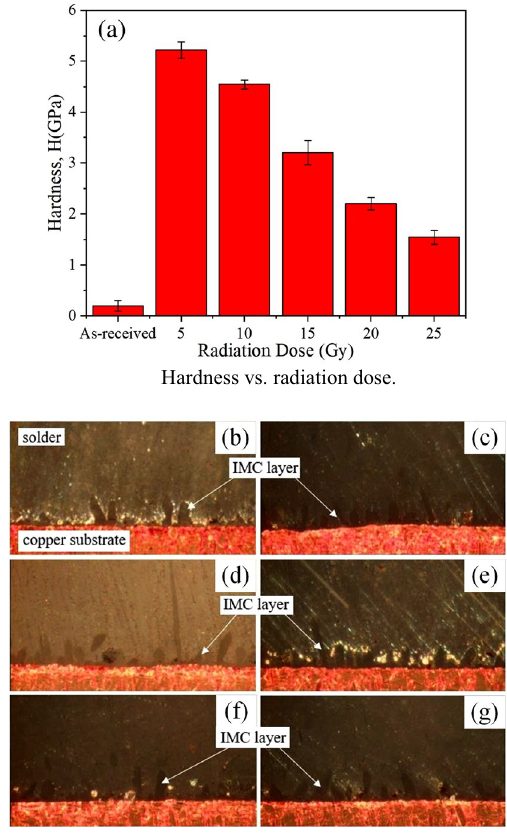
Figure 9 Microhardness and microstructure of SAC305 solder joints before and after irradiation